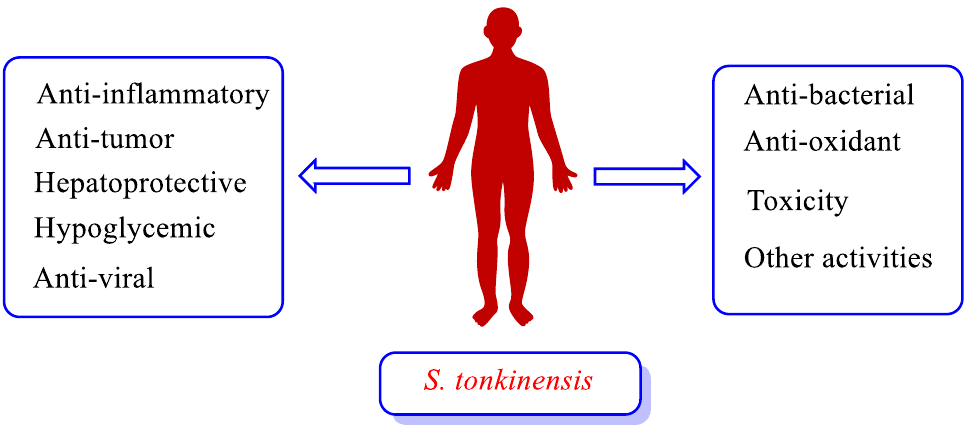
Figure 2. The biological activities of S. tonkinensis.